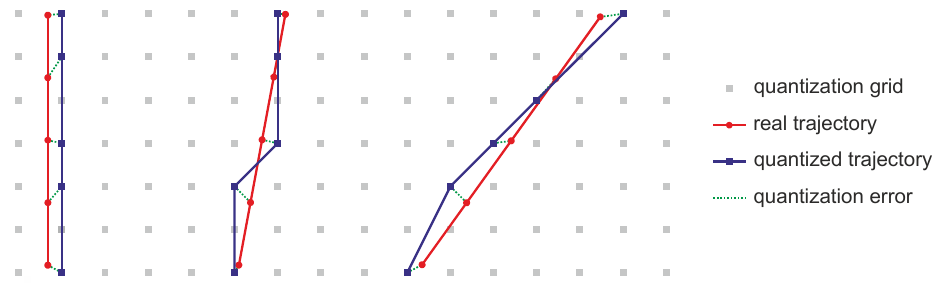
Figure 3. Illustration of the quantization effect on the positions supplied by a GPS receiver, showing that quantified trajectories register (i) position errors; and (ii) speed errors, as shown by the variable distances between the blue rectangles; and (iii) heading error, which are higher in trajectories nearby, but different from, the direction of any coordinate axis.